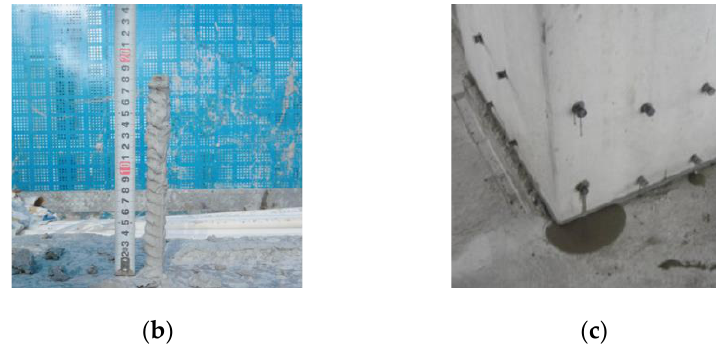
Figure 2. Types of partial defects in a grouted sleeve. ( a ) Foreign bodies bonded to rebars. ( b ) Insufficient anchorage length of rebar. ( c ) Untimely grouting closure.